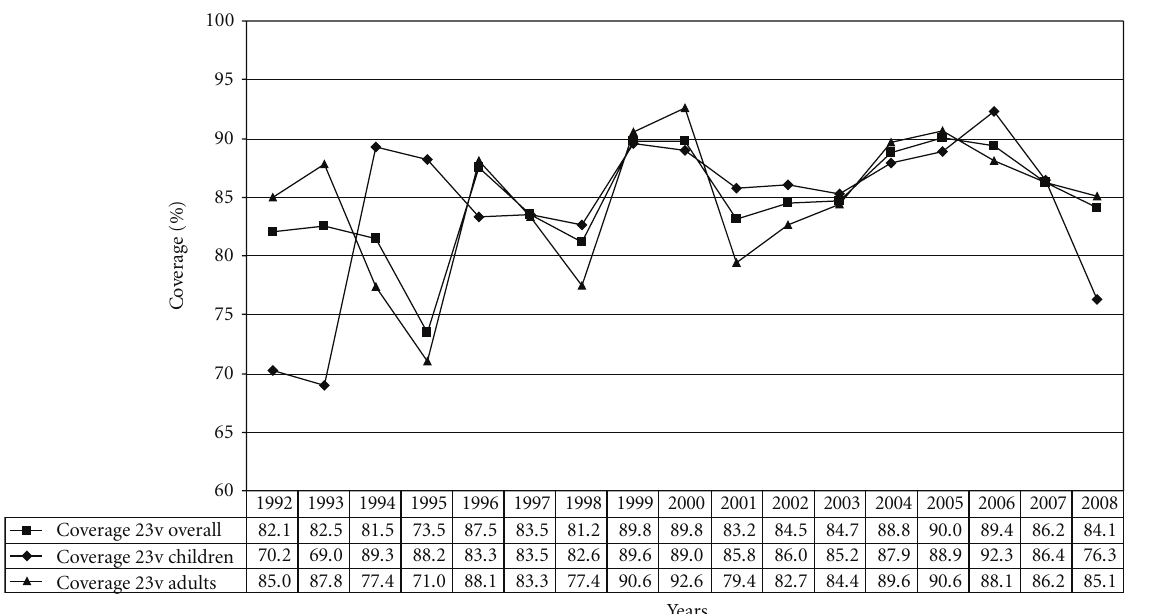
Figure 5: Coverage of the 23v-pneumococcal polysaccharide vaccine for children ( n = 2,948), adults ( n = 6,446), and overall ( n = 9,394)